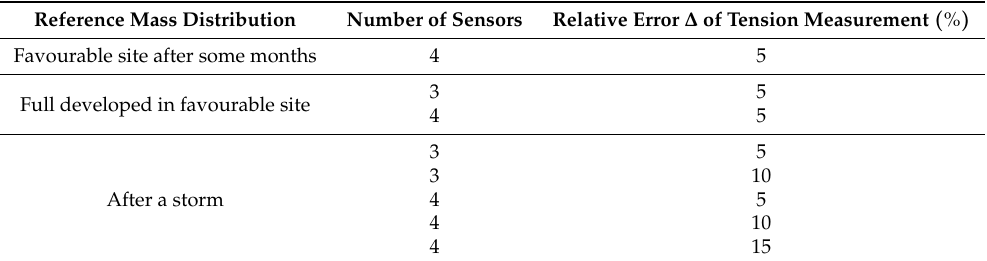
Table 8. Excluded scenarii from analysis due to a low size of posterior